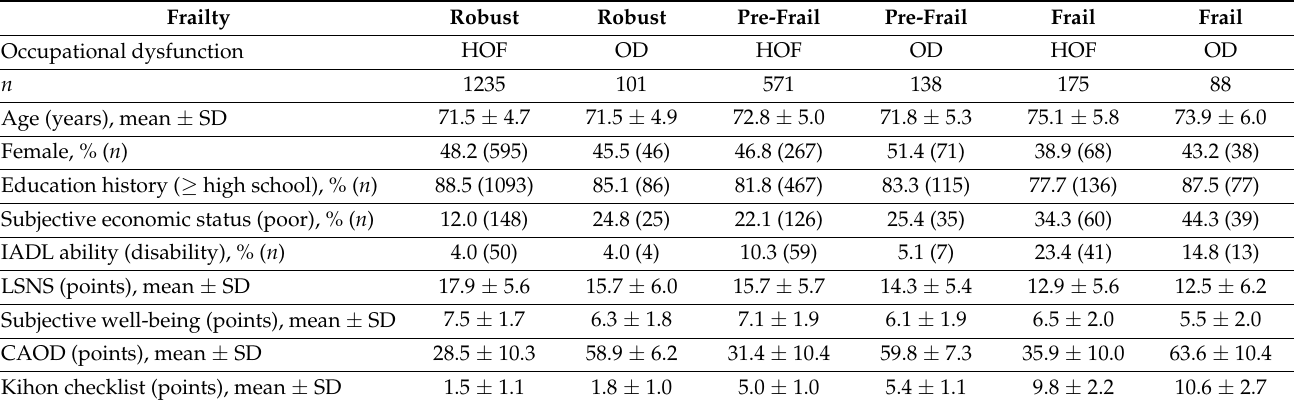
Table 1. Participants’